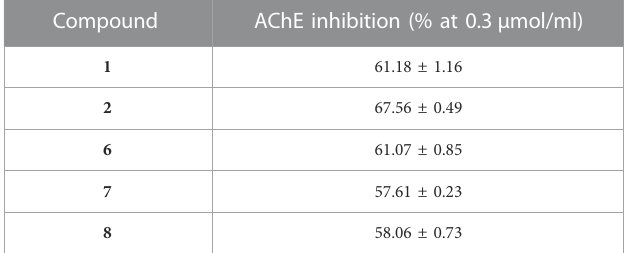
TABLE 3 AChE inhibitory activities of fi ve dibenzofurans from U. diffracta